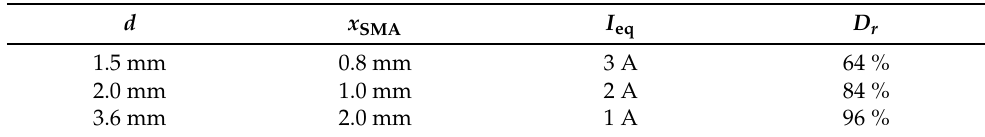
Table 3. Achieved energy reduction of MR damper in combination with SMA under various load- ing